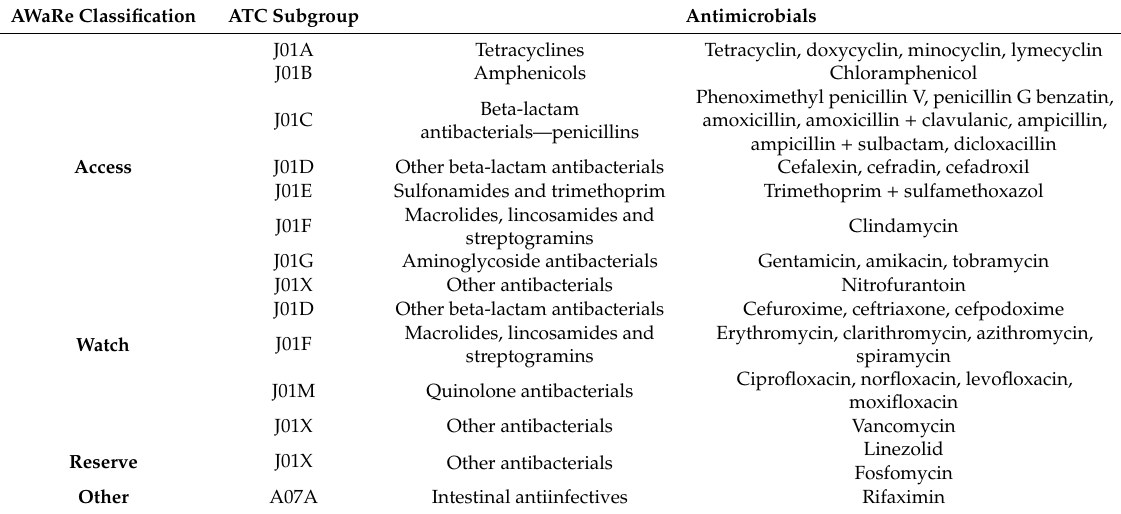
Table 6. Antibiotics available in the Colombian Health System categorized according to the AWaRe